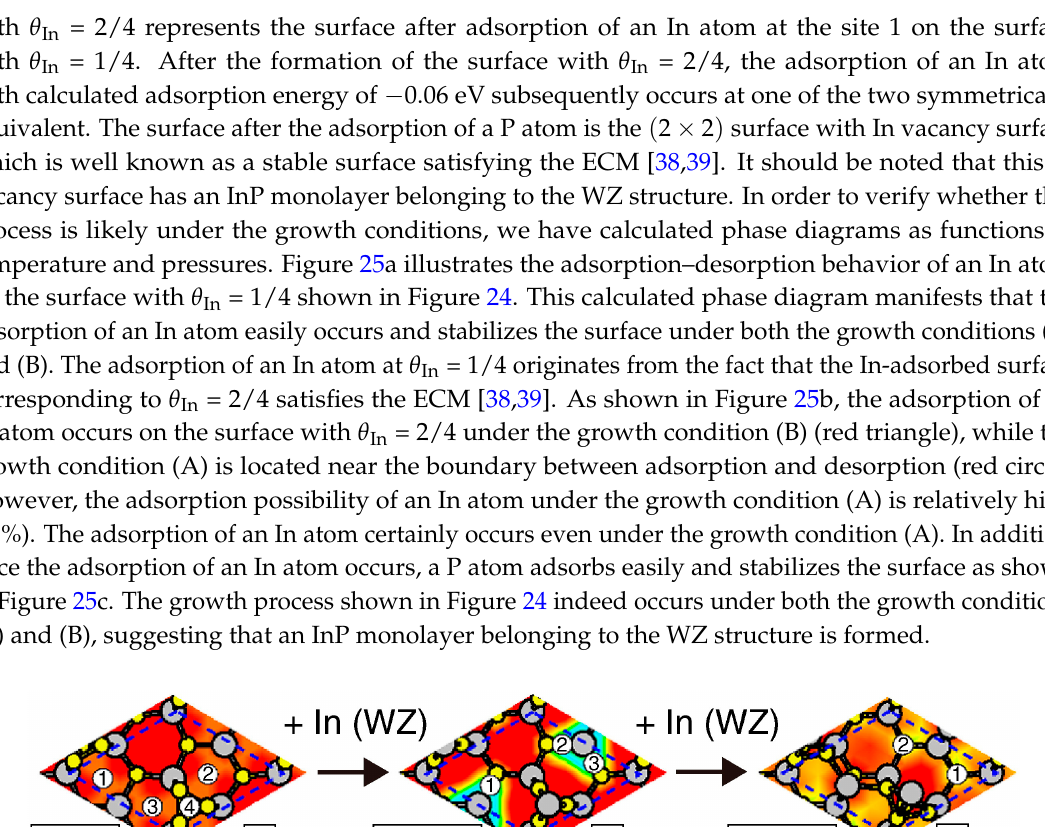
Figure 25. Calculated phase diagrams as functions of temperature and pressure in the growth process shown in Figure 21. Panels ( a ) and ( b ) show adsorption–desorption behavior of an In atom on the surface with θ In = 1/4 and 2/4, respectively. Panel ( c ) illustrates adsorption–desorption behavior of a P atom on the surface with θ In = 3/4. Regions with hatched lines correspond to atom-adsorbed regions. Red circles and triangles represent the growth conditions (A) and (B), respectively. Reprinted with permission from [97]. Copyright (2013) by Elsevier.